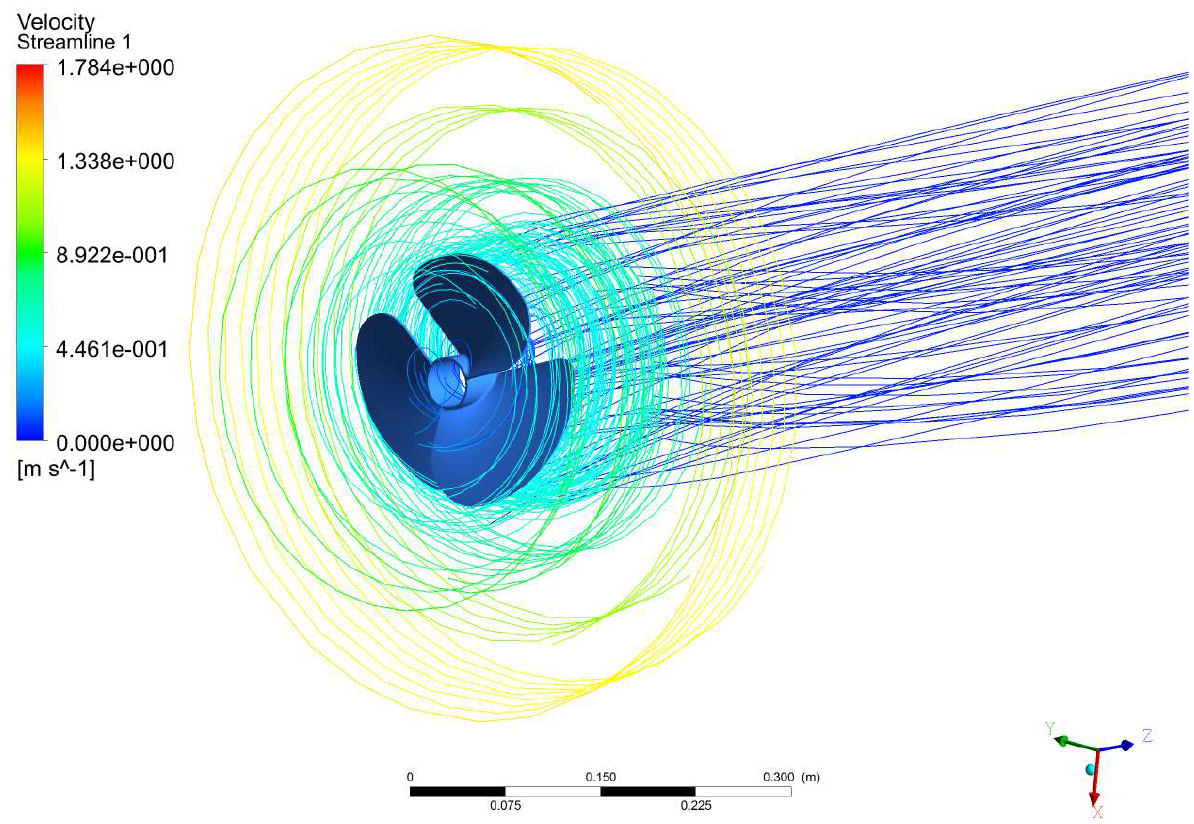
Figure 14. Velocity variations of 50 RPM.